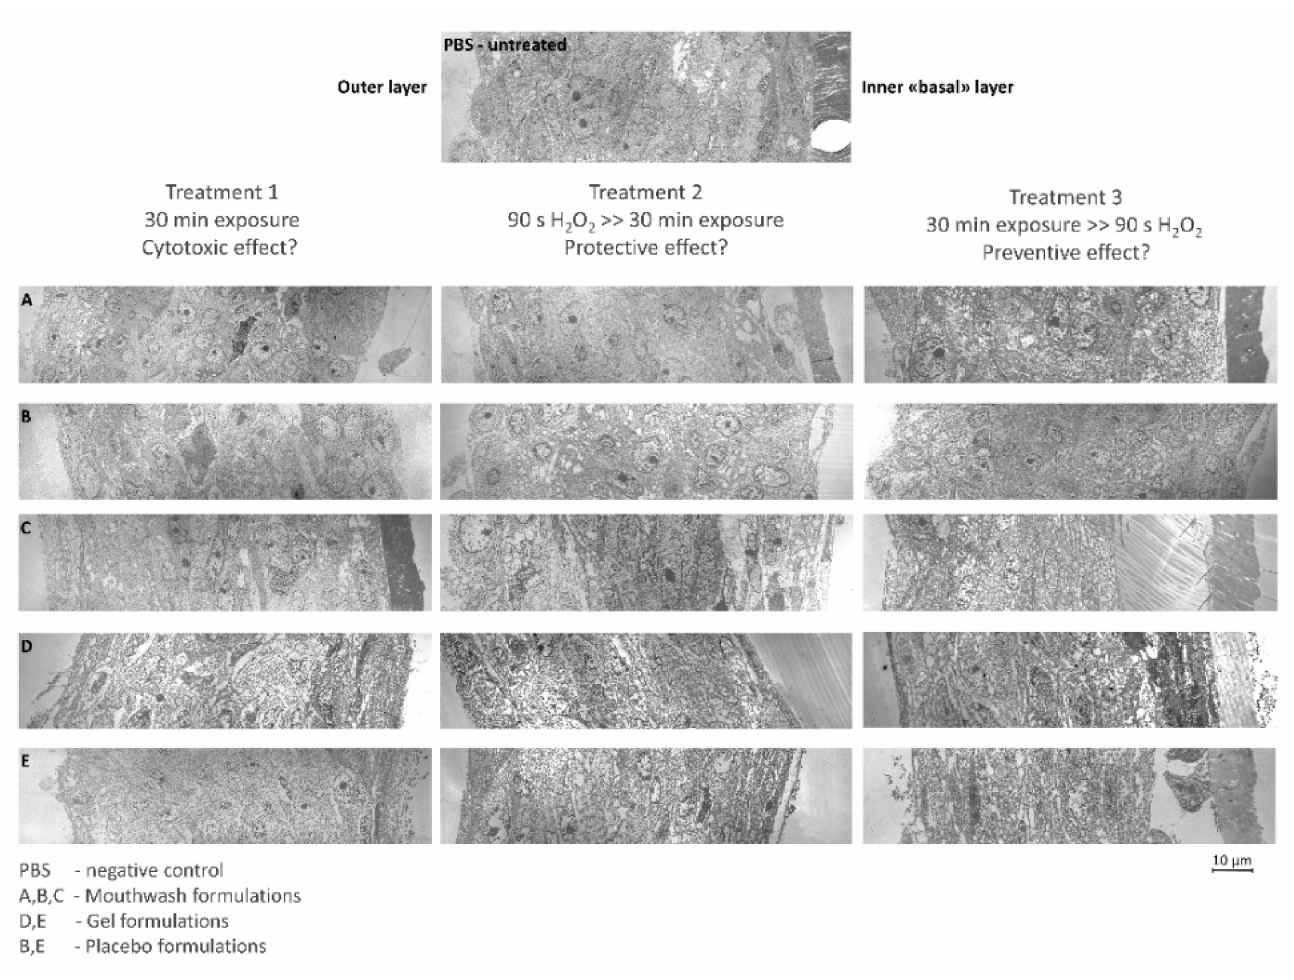
Figure 6. ( A – E ) TEM images of RHOE sections. The outer layer of the epithelium is oriented as shown in the upper image of PBS untreated. The different layers that characterize the human oral epithelium from the basal ( right ) to the keratinized surface layer ( left ) can be observed (Scale bar: 10 µ m). Each picture letter indicates the corresponding formulation. Higher magnification fields were acquired, then photo-stitching and contrast optimization were performed to obtain high-resolution fields spanning the whole thickness of the